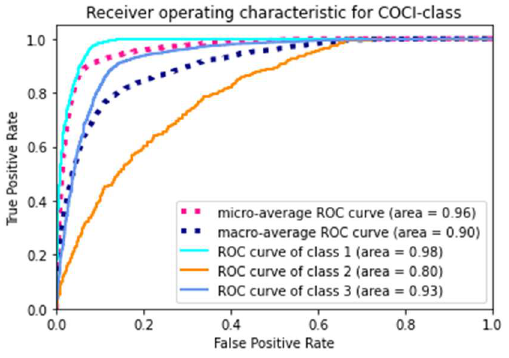
Figure 2. The receiver operating characteristic curve of the final model.